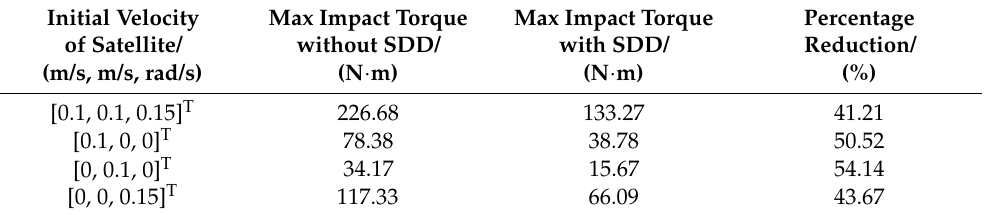
Table 1. SDD impact resistance at different initial velocities of spacecraft.